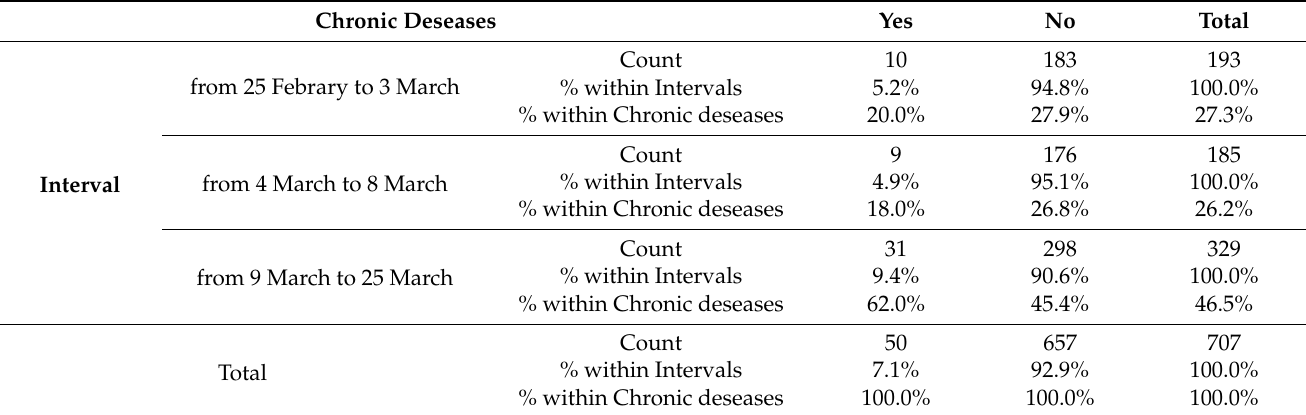
Table 6. Time interval in relation to participants’ chronic